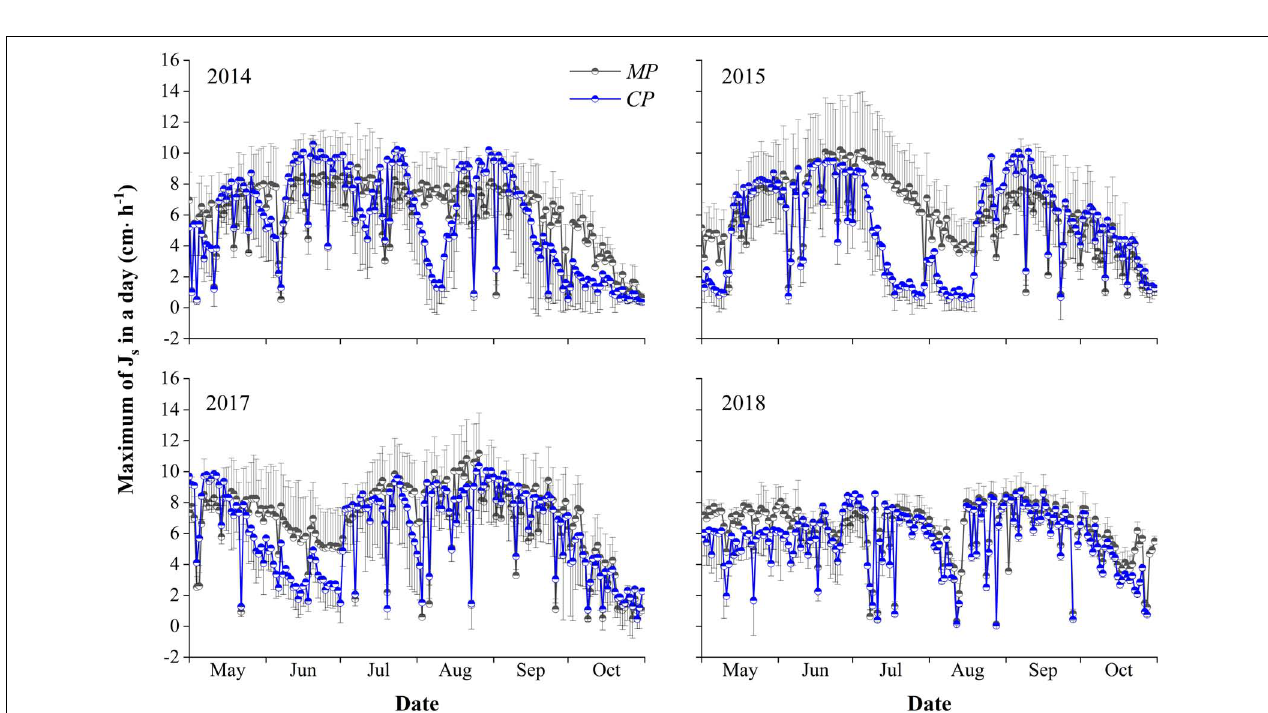
FIGURE 2 | Inter-seasonal dynamics of daily precipitation and daily relative extractable soil water (REW) in the 4 years of xylem sap flux measurement. The dotted horizontal lines represent the threshold value of soil water availability at REW = 0.4.